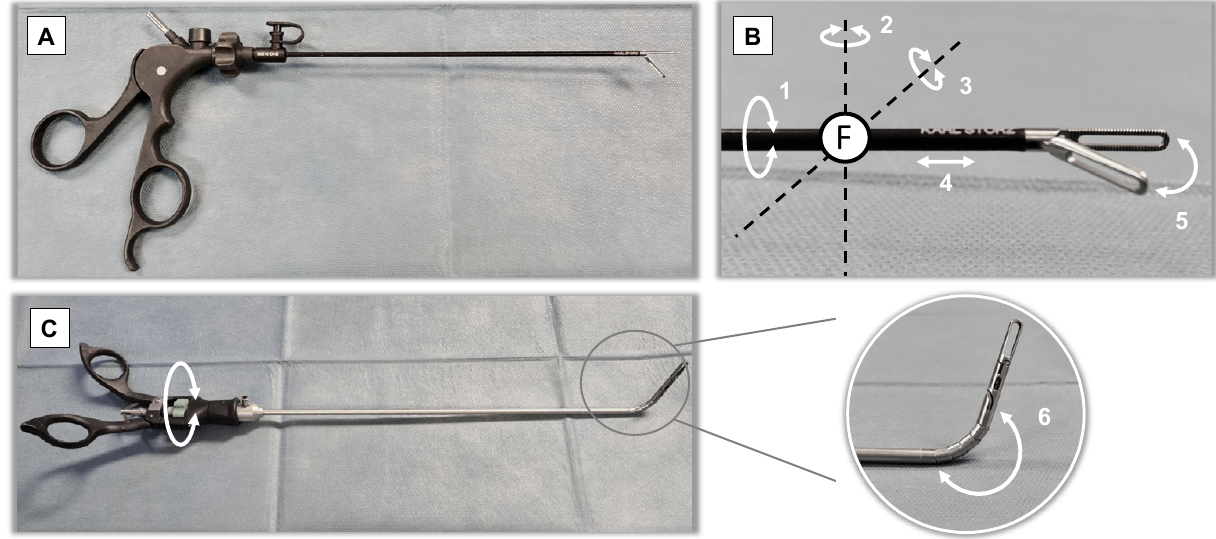
Figure 2. ( A ) Conventional laparoscopic instrument; ( B ) 5 movement’s degrees of freedom of a conventional laparoscopic instrument; ( C ) 6th degree of freedom given from a curved instrument. F = fulcrum (fulcrum effect given by trocars).